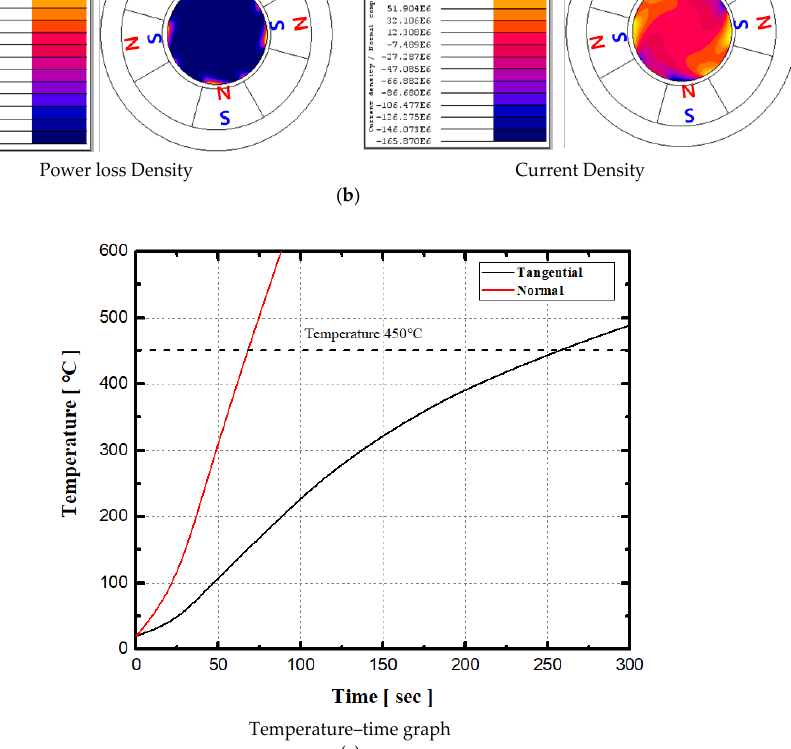
Figure 9. Analysis result according to permanent magnet flux direction change: ( a ) tangential direction result; ( b ) normal direction result; ( c ) temperature result. The temperature result according to the changes in the permanent magnet flux direc- tion showed that the temperature increased the heating time. As shown in Figure 9, in the case of the tangential model for the flux direction, the heating time and energy consump- tion at which the temperature of the billet reached 450 °C were approximately 260 s and 302.57 kWh/ton, and in the normal model, they were approximately 70 s and 287.01 kWh/ton, respectively. Thus, the normal model for the flux direction improves the heating time by approximately 73% and the energy consumption by approximately 5% compared to the tangential mode. 4.2. Heating Effect Based on Number of Magnets In this study, the effects of the increasing number of permanent magnets from 4 to 16 in the tangential and normal models, as mentioned above, were analyzed. All the perma- nent magnets were arranged with the same clearance, and the same flux direction arrange- ments of tangential and normal models were applied to the analysis. The results of electromagnetic – thermal analysis based on the increased number of permanent magnets are shown in Figures 10 and 11. In the normal model, the power loss of the billet gradually decreased as the number of magnets increased. In the normal model, the hourly power loss of the billet gradually decreased as the number of magnets increased. This is because the magnetic force transmitted into the billet decreased despite the increase in the number of magnets and the decrease in the spacing. The biggest differ- ence between the normal and tangential models is the difference in the form of the mag- netic flux penetrating into the billet depending on the polarity direction; the normal model shows a deeper penetration into the billet than the tangential model. In contrast, it can be observed that the power loss gradually increased with the number of magnets for the tan- gential model, and an inflection point was reached when the number of permanent mag- nets was 12. Furthermore, the same phenomenon appears in the graphs of the time to reach 450 °C and the number of magnets. As described in the four cases above, this is due to the interference between permanent magnets. The narrower the clearance was, the lower the heating efficiency was as the magnetic flux, which should penetrate the billet, flows into the adjacent permanent magnet.